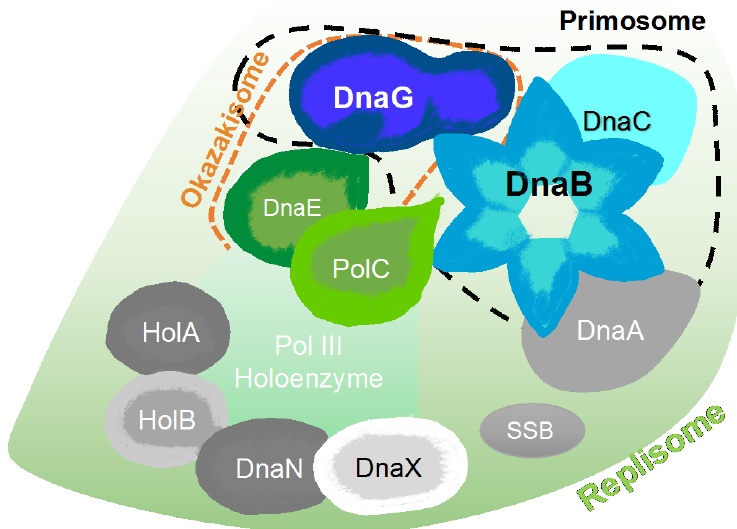
Figure 6. Schematic representation of major protein-protein interactions at a bacterial DNA replication fork created, according to the interaction map of DNA replication proteins [54]. The map is comprised of the DnaA replication initiator, the DnaB helicase, the DnaC helicase loader, the DnaG primase, PolC and DnaE polymerases, the single-stranded DNA binding protein (SSB), the DnaN β clamp, and three clamp loader subunits (HolA, HolB, and DnaX).